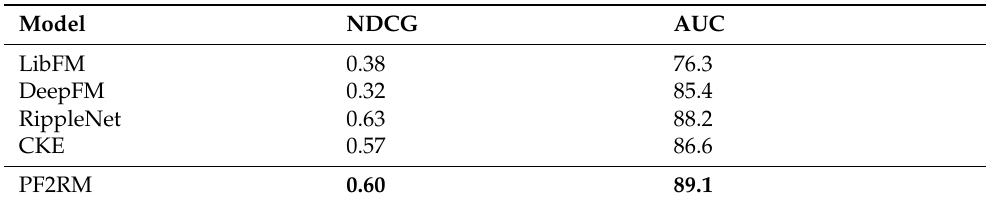
Table 2. Evaluation table of cold-start recommendation